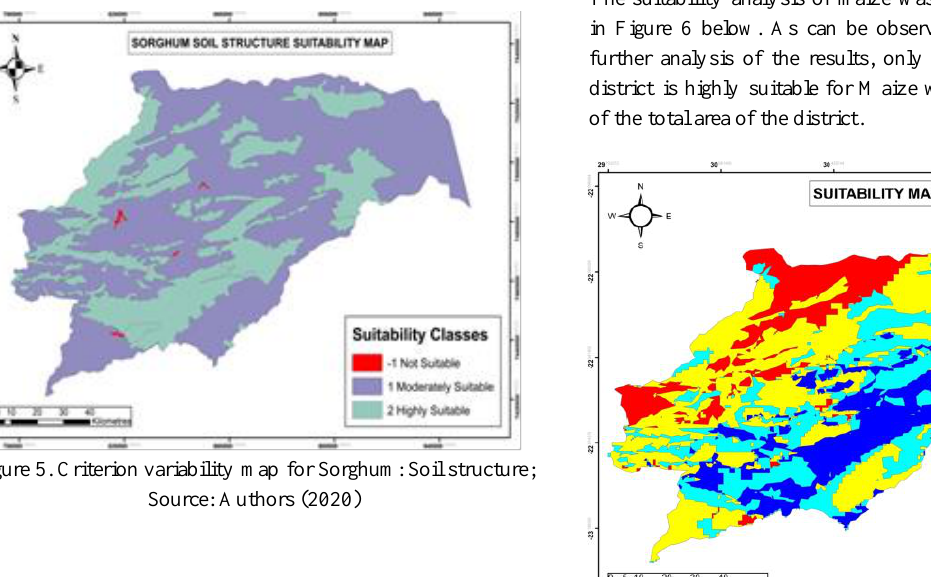
Figure 4. Criterion variability map for Sorghum: Soil pH; Source: